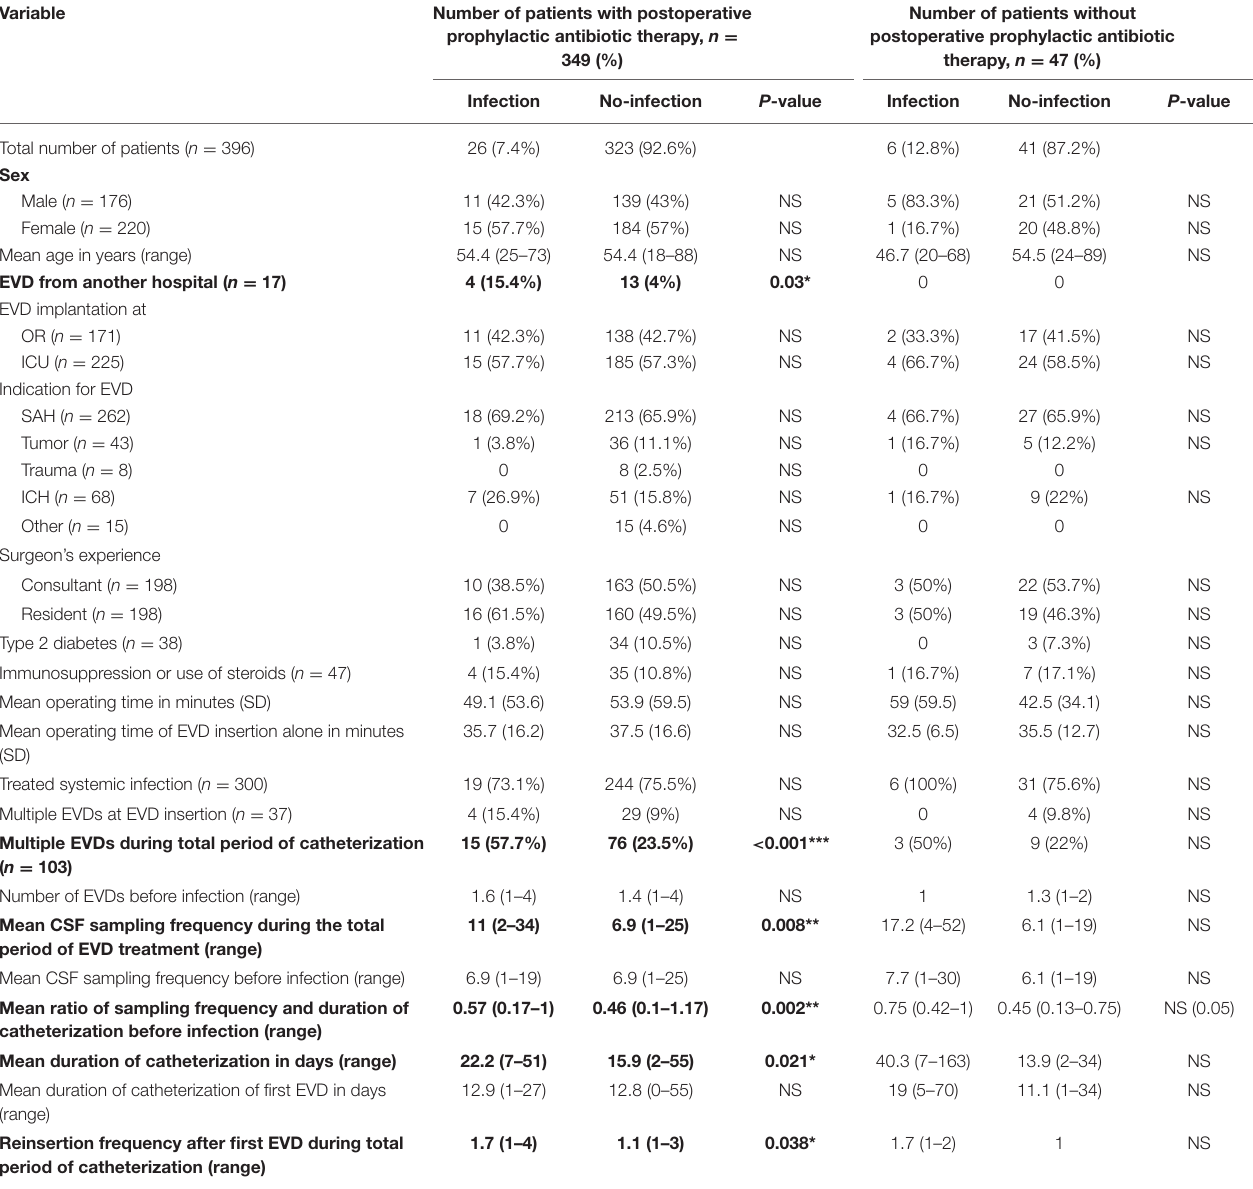
TABLE 6 | Differences in patient characteristics and EVD management between patients with and without EVD associated infections.